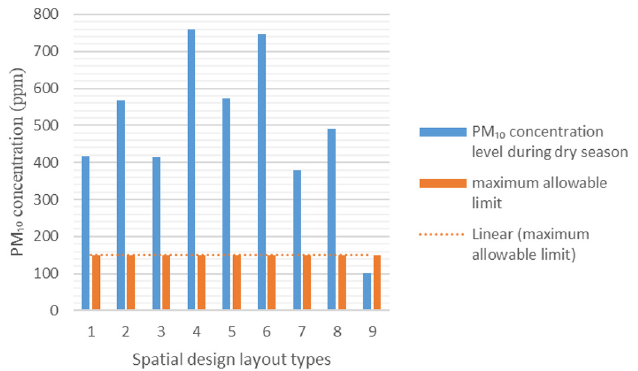
Fig. 5. PM 10 concentration levels in the different spatial design layouts during dry season.